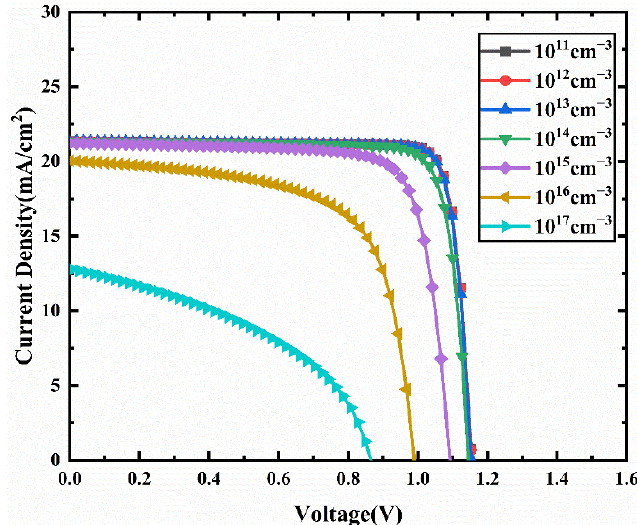
Figure 11. Comparison of J-V characteristic curves for different bulk defect density.